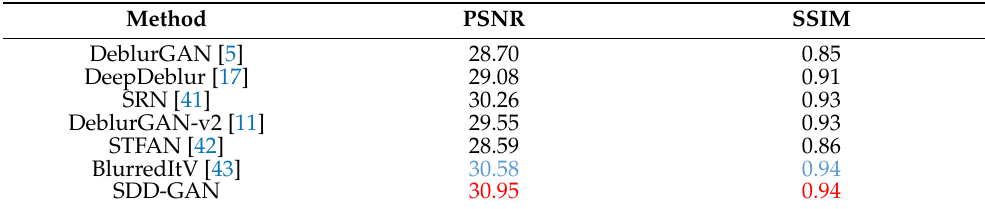
Table 2. Average PSNR and SSIM for different deblurring methods on the GoPro dataset. The highest scores are highlighted in red, and the second highest scores are highlighted in blue. PSNR